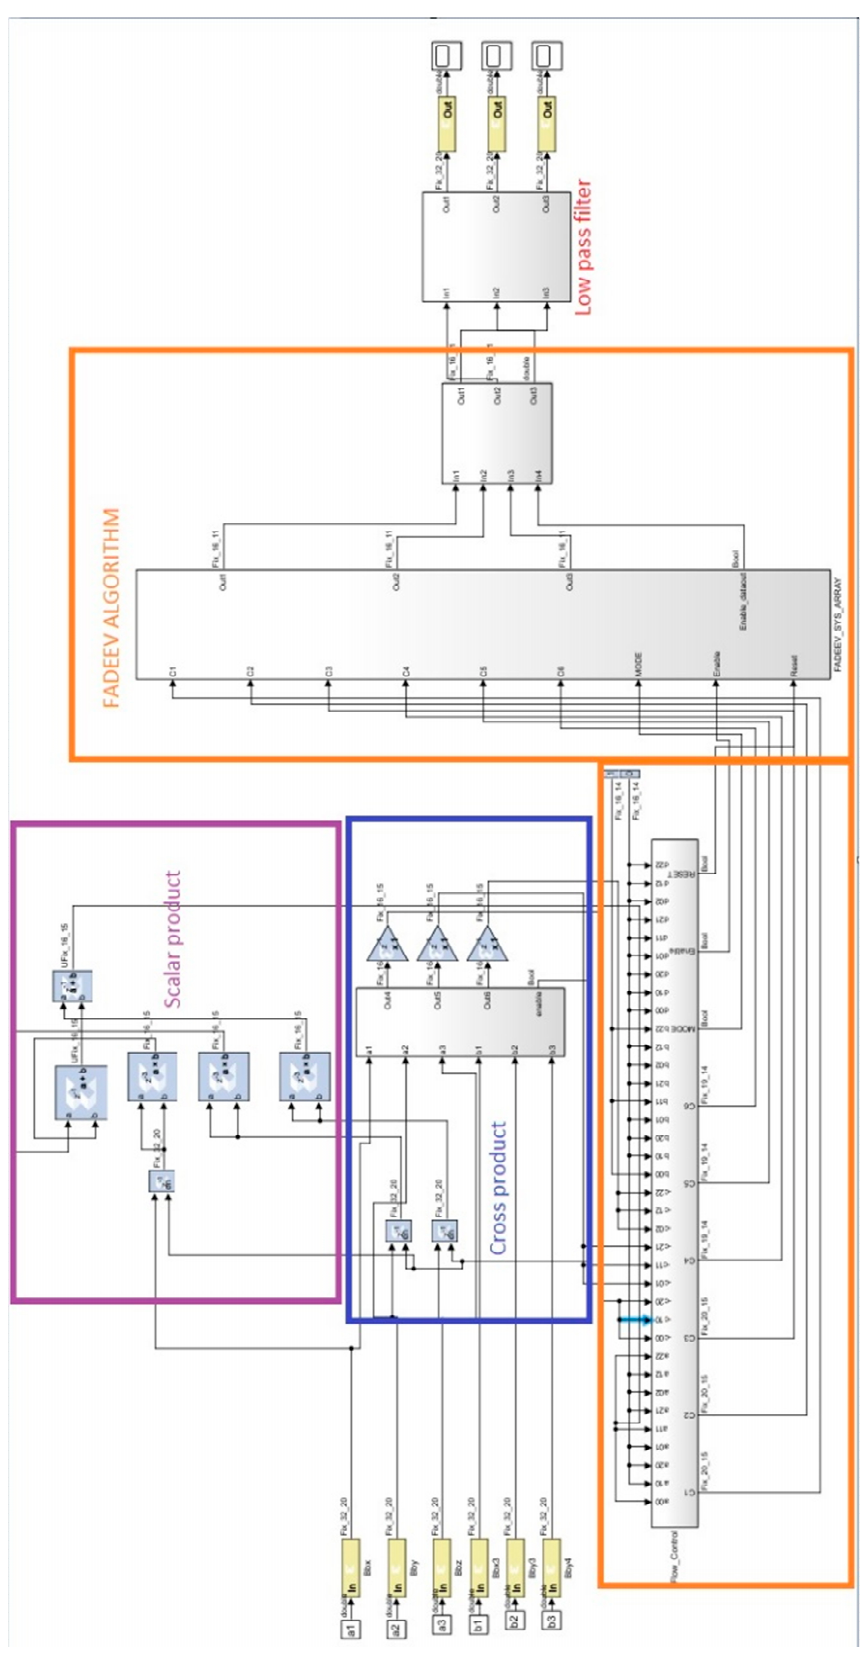
Figure 10. Main blocks of the attitude determination algorithm implemented on Field Programmable Gate